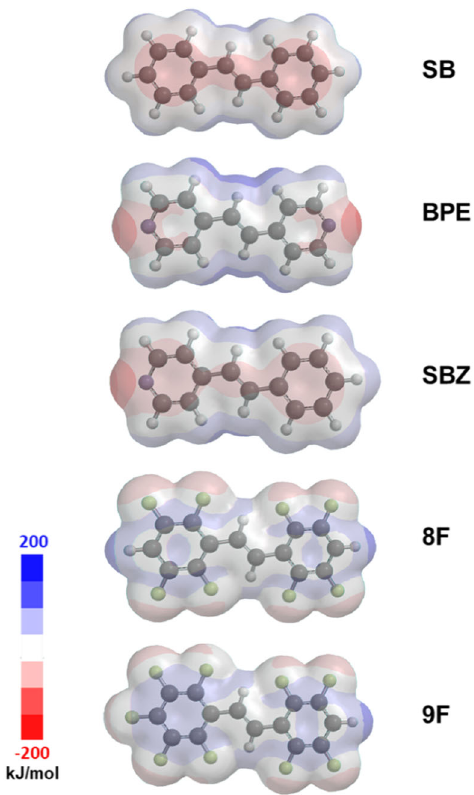
Fig. 3 DFT calculated electrostatic map for functionalized alkenes (blue = positive electrostatic charge, red = negative electrostatic charge). Note terminal ends of 9F to exhibit opposite charges.